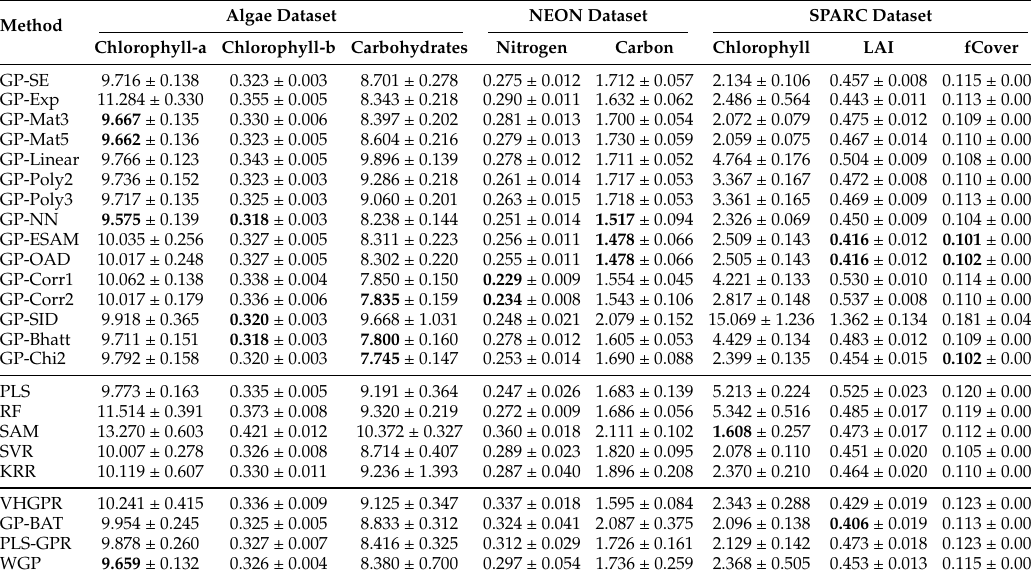
Table 4. Predictive performance of different methods on all three datasets measured in root mean squared error